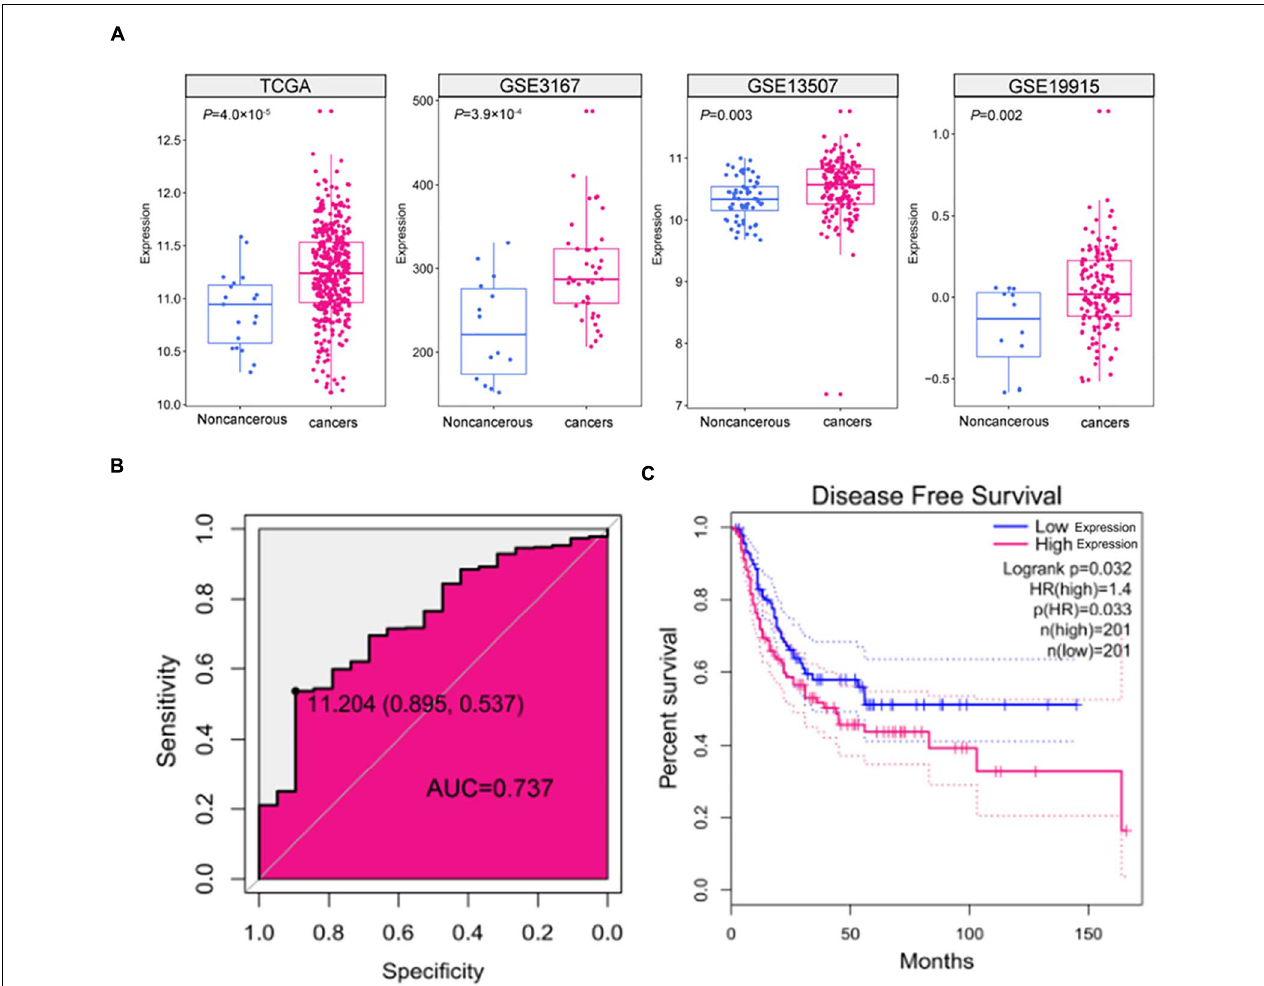
FIGURE 1 | The expression and clinical significance of SNHG9 in HCC. (A) SNHG9 expression in non-cancerous liver tissues and HCC samples, based on data from the public dataset. (B) ROC curve and AUC of SNHG9. (C) Kaplan–Meier survival curves of the two groups of patients based on TCGA data. Red: Patients with high SNHG9 expression. Blue: Patients with low expression of